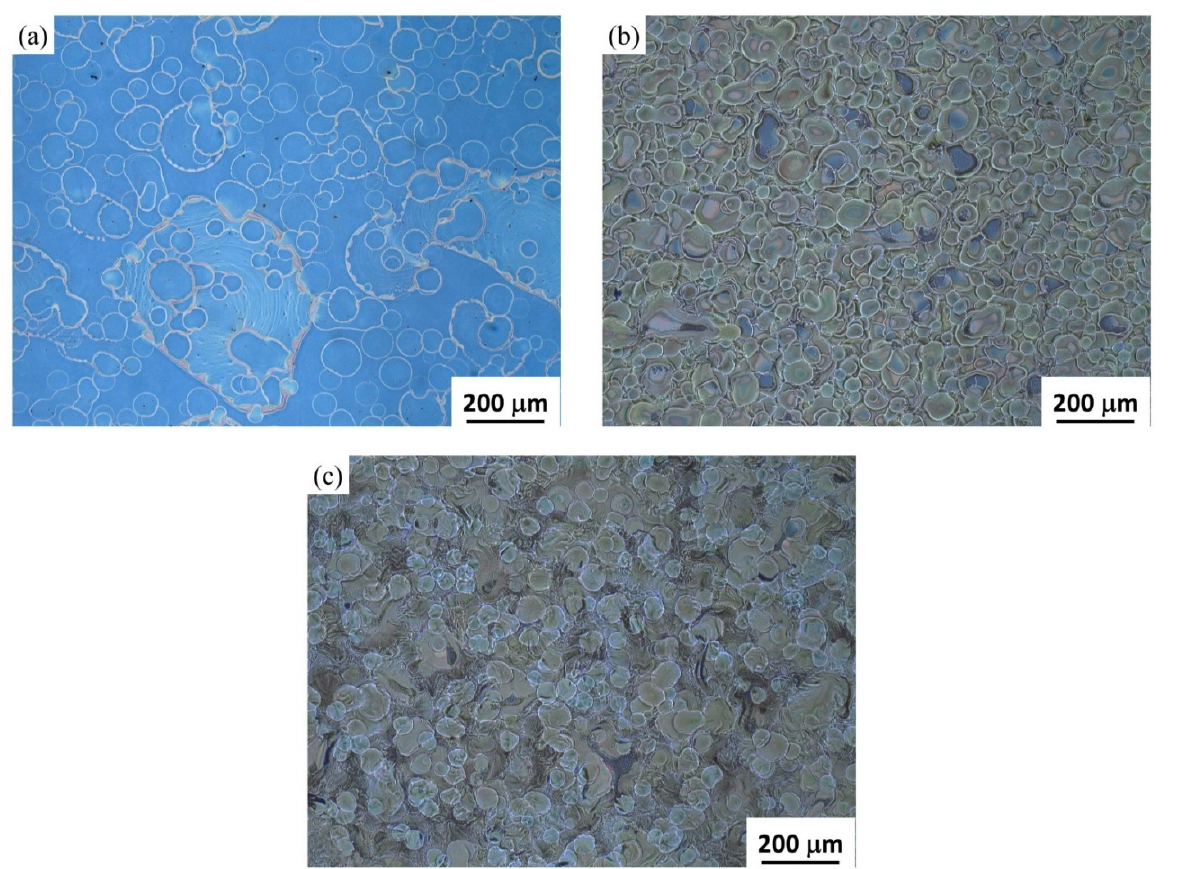
Figure 5. 2D optical images of spray-on P3HT:PCBM films, taken by CLSM, showing the surface features; ( a ) one spray pass, ( b ) 15 spray passes, and ( c ) 30 spray passes. Carrier air pressure is 0.1 MPa, flow rate is 1 mL/min, and concentration is 1.8